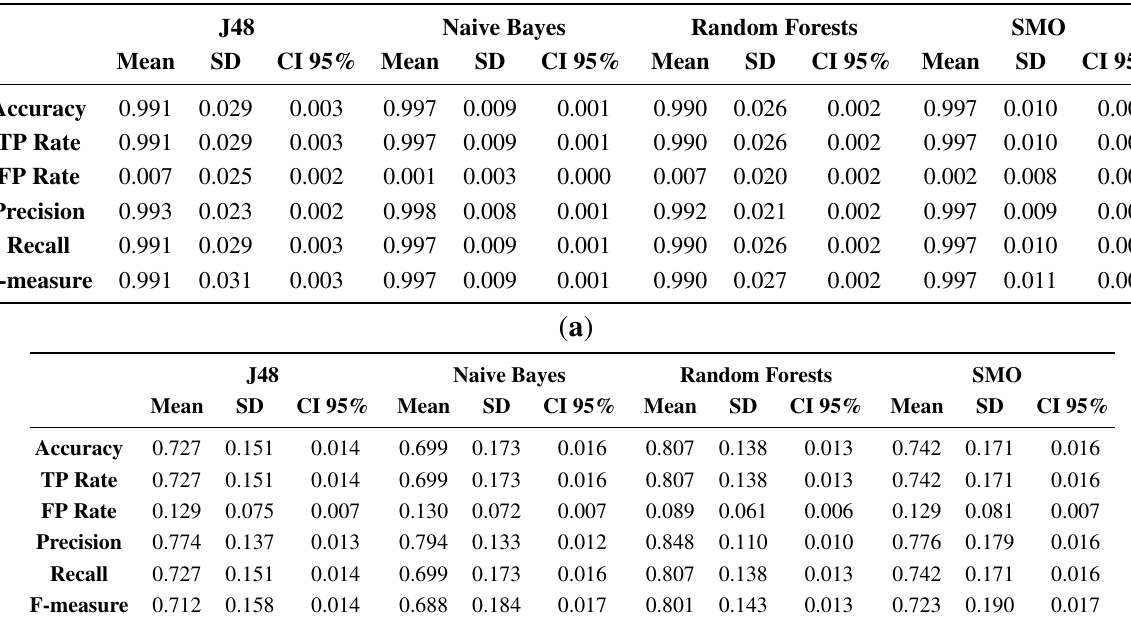
Table 2. Learning performance for the three datasets. Note: FP = False Positive. ( a ) Learning performance for dataset D ( turned: left, forward, 1 right ); ( b ) learning performance for dataset D ( looking: left, forward, right ); ( c ) learning 2 performance for dataset D ( pointing: left, forward, right ). SMO, Sequential Minimum 3 Optimization; SD, standard deviation; CI, confidence